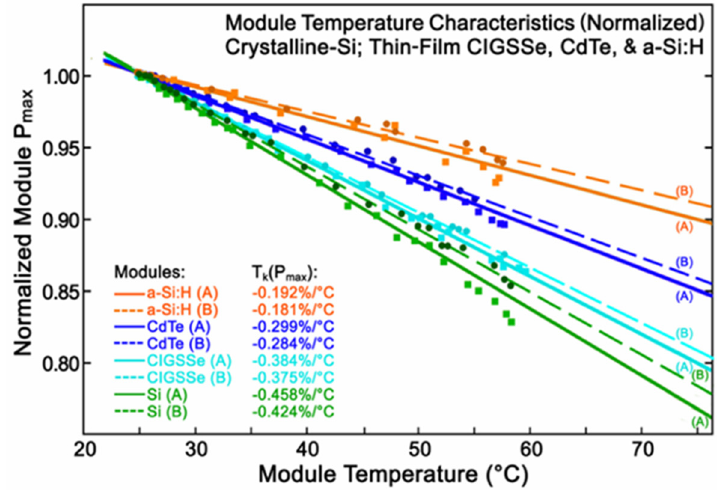
Figure 2. Normalized module P max as function of module temperature for the four module technol- ogies in this study in order to determine the temperature coefficients [T k (P max )]. The separation of the lines represents the range of measurements for several modules of each type (see Table 1).